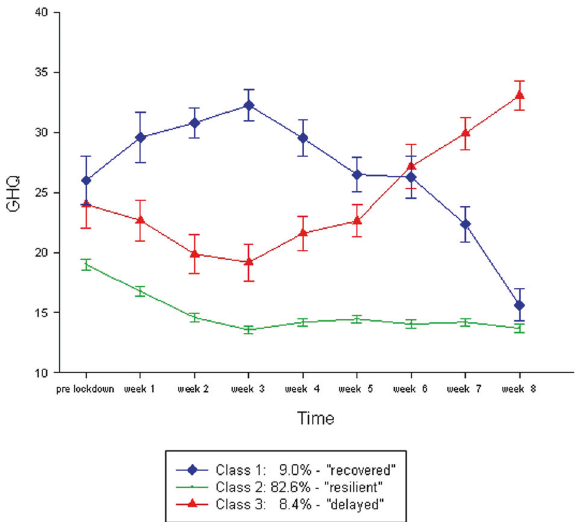
Fig. 4 Quadratic growth mixture model (GMM) with three-class solution. Final proportions for the latent classes based on their most likely latent class membership: “ recovered ” class 1 blue = 9.0% ( n = 47), “ resilient ” class 2 green = 82.6% ( n = 432), “ delayed dysfunction ” class 3 red = 8.4% ( n = 44).